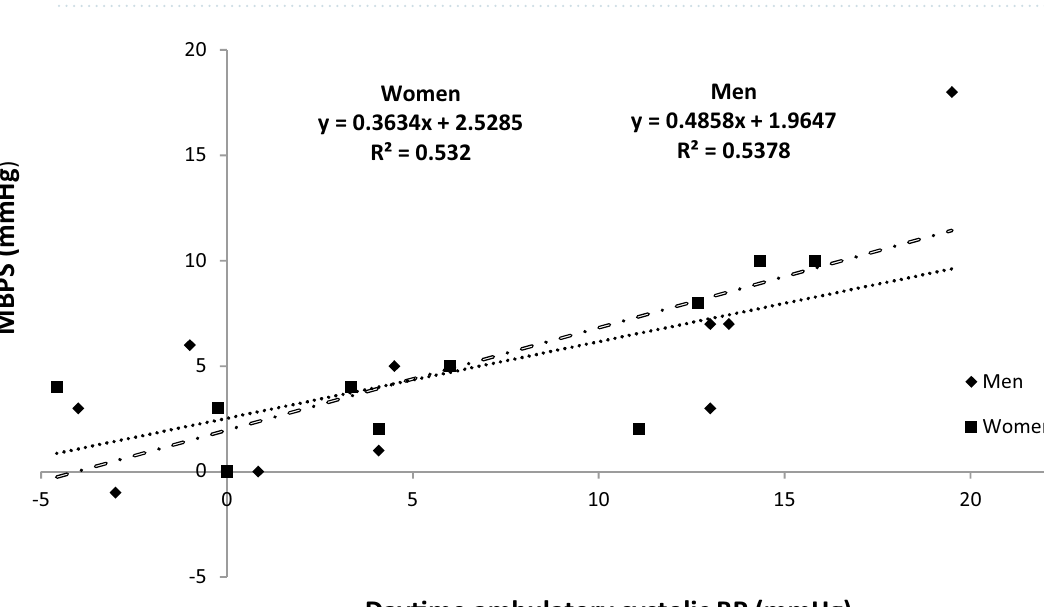
Figure 5. Regression line and plot of changes in morning blood pressure surge (MBPS) and changes in 2-h systolic blood pressure (BP) after waking following 10 weeks of isometric resistance training for men and women.